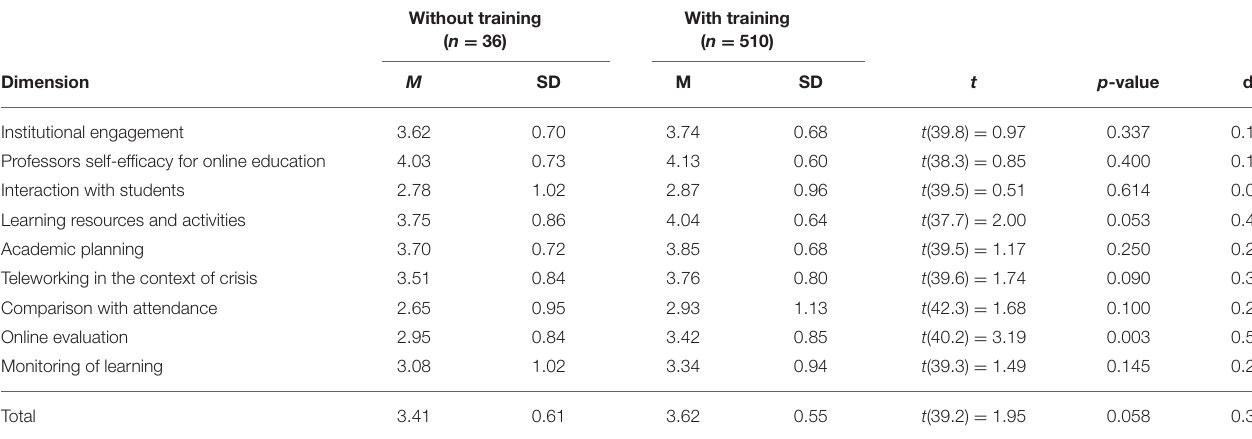
TABLE 4 | Differences in expectations between people with and without training in virtual education.